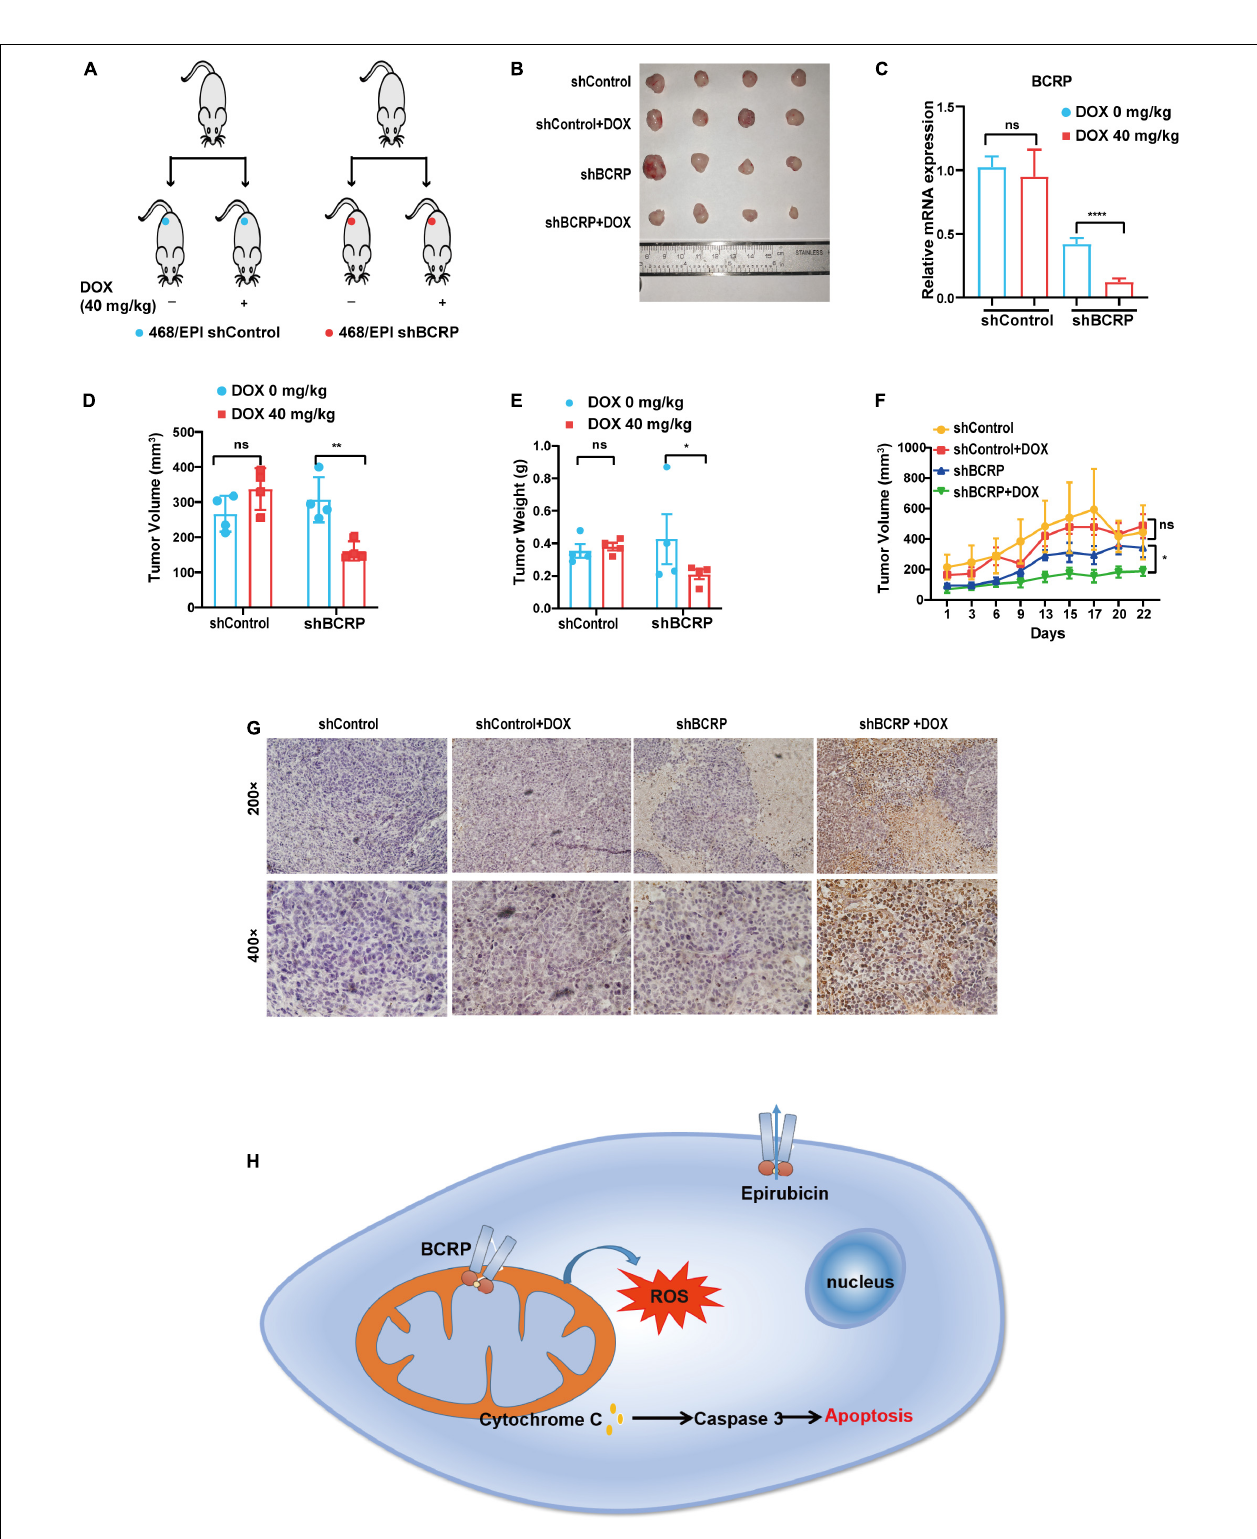
FIGURE 7 | Knockdown of BCRP inhibits the proliferation of drug-resistant breast cancer cells in vivo . (A) Schematic depicting the overall design of in vitro experiments. (B) Representative image of tumors from mice receiving indicated treatments. (C) Expression level of BCRP mRNA in xenograft tumors in mice receiving indicated treatments (independent Student’s t -test). (D) Volume of tumors in mice receiving indicating treatments (independent Student’s t -test). (E) Weight of tumors in mice receiving indicated treatments (independent Student’s t -test). (F) Growth curves of inoculated tumors in mice receiving indicated treatment (two-way